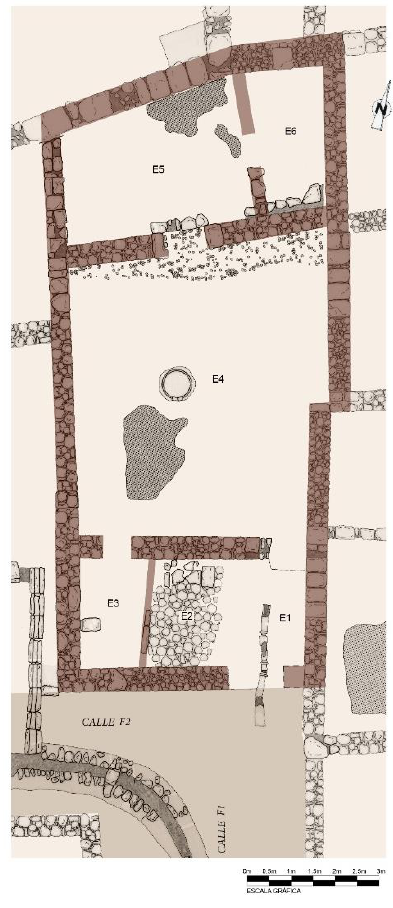
Figure 15. Variant 2. House 51. Plan and room distribution.